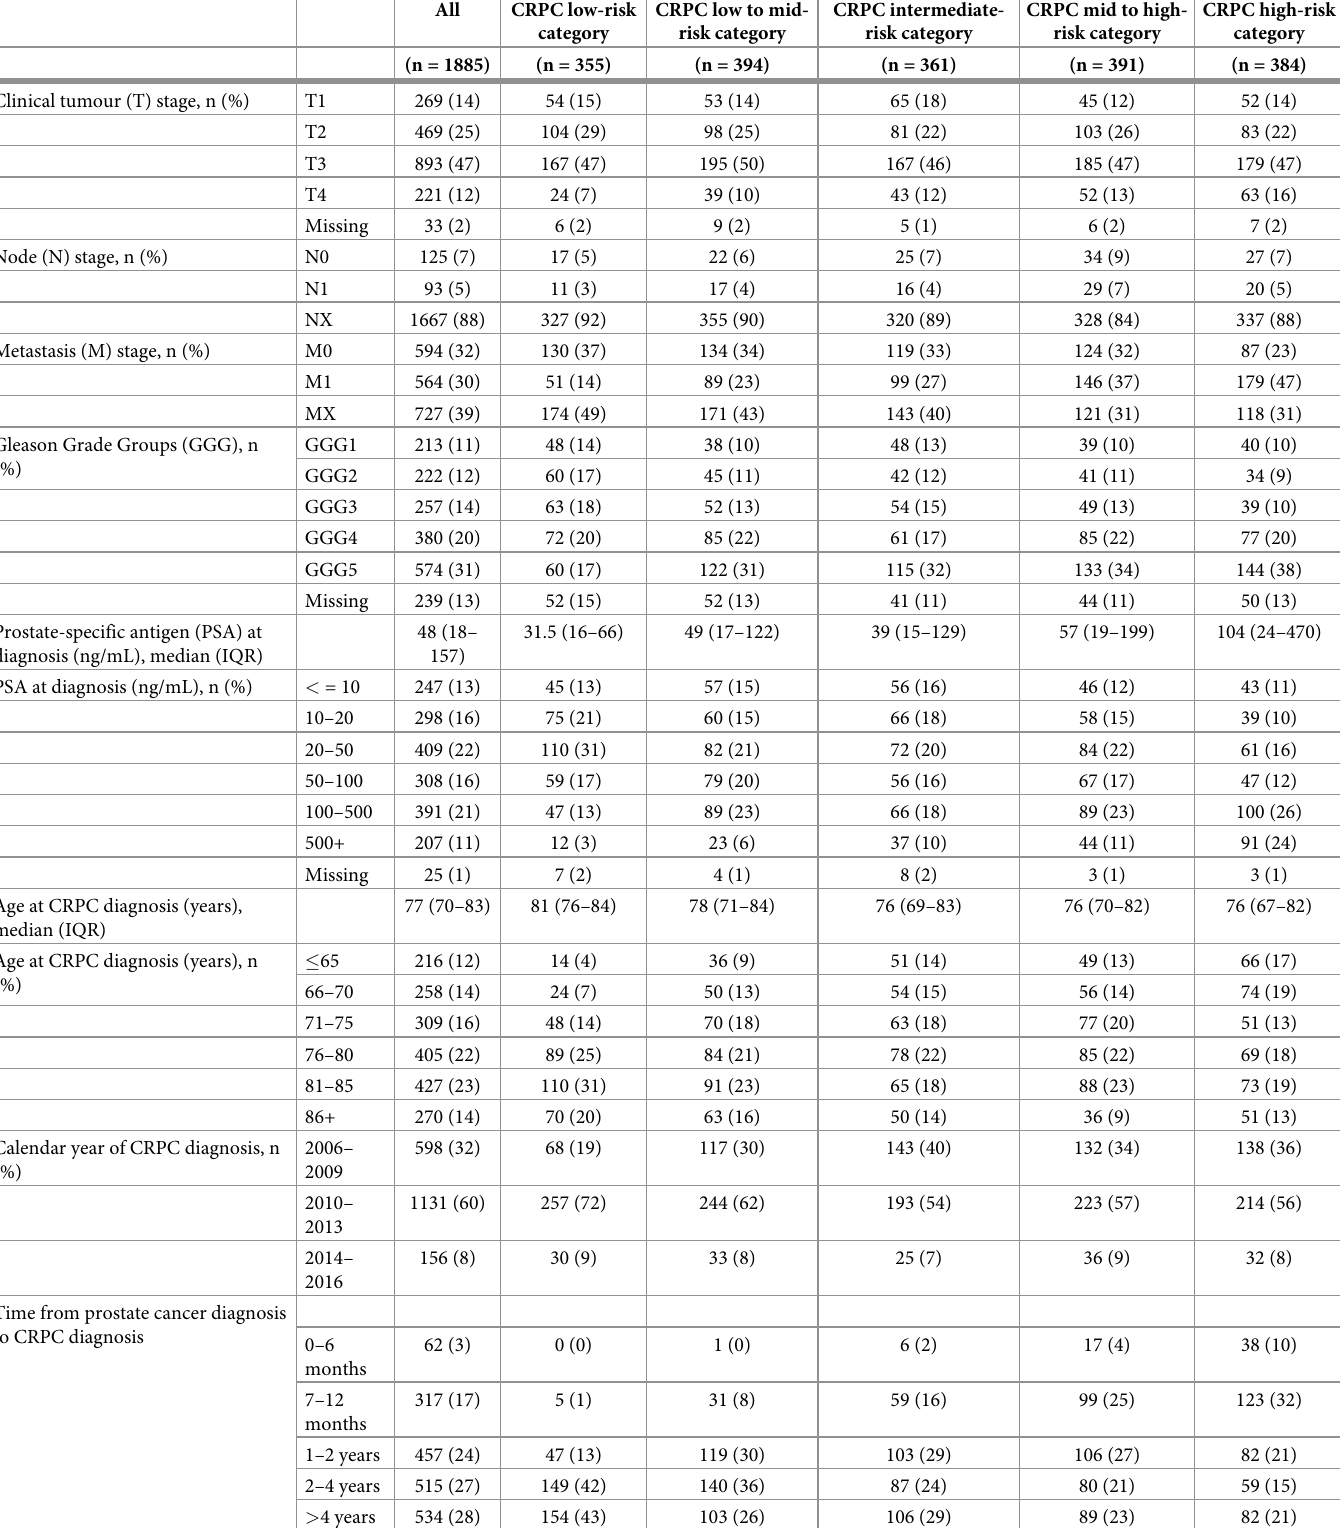
Table 1. Baseline characteristics of men with castration-resistant prostate cancer (CRPC) in the Uppsala-O¨rebro PSA cohort (UPSAC) database.